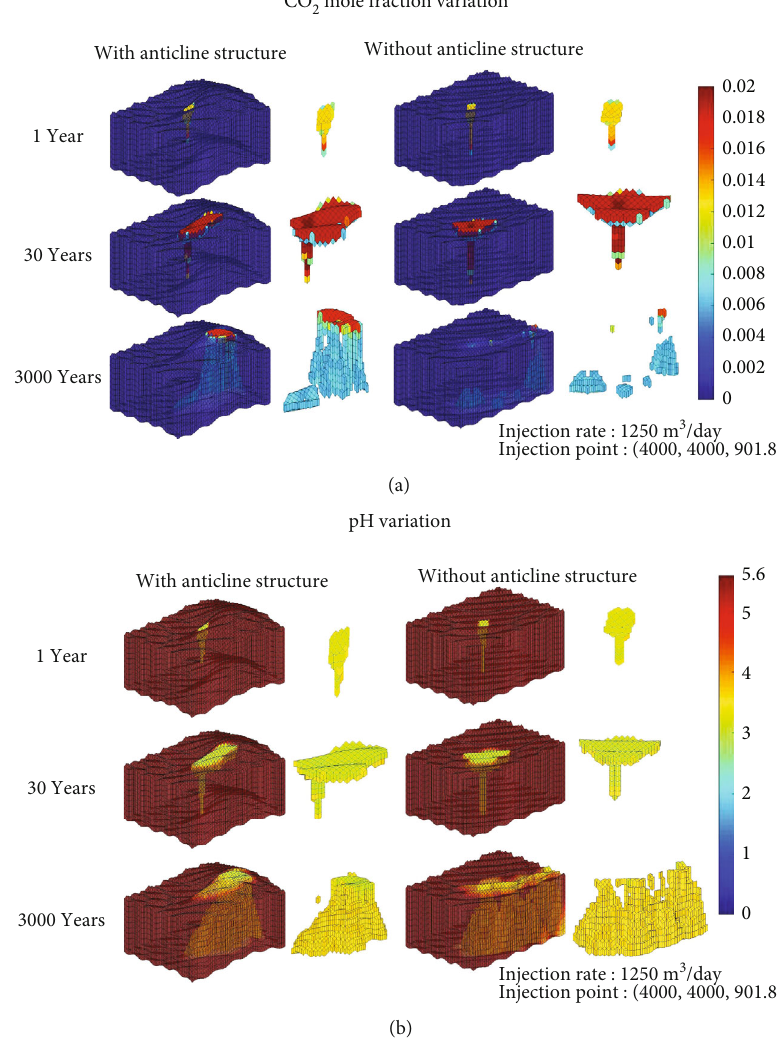
Figure 6: In fl uence of caprock morphology on (a) CO